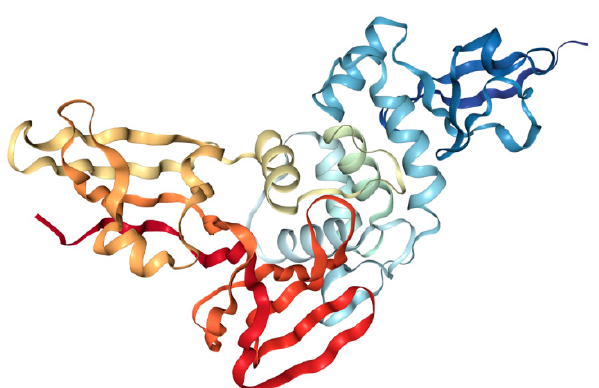
Figure 5. Crystal structure of PL pro protease from SARS-CoV-2. Subdomains are color-coded and include N-terminal ubiquitin-like domain in dark blue, thumb subdomain in light blue, palm domain in red and fingers domain in orange. Image obtained by Osipiuk et al., 2021 [60], PDB entry: 7JIW.